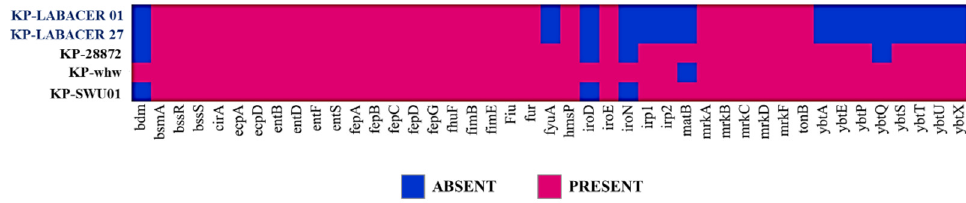
Figure 7. Phylogenetic tree constructed with sequences of genes encoding ribosomal protein subunits (rps) of Klebsiella pneumoniae (KP), Klebsiella quasipneumoniae (KQ), and Klebsiella variicola (KV).